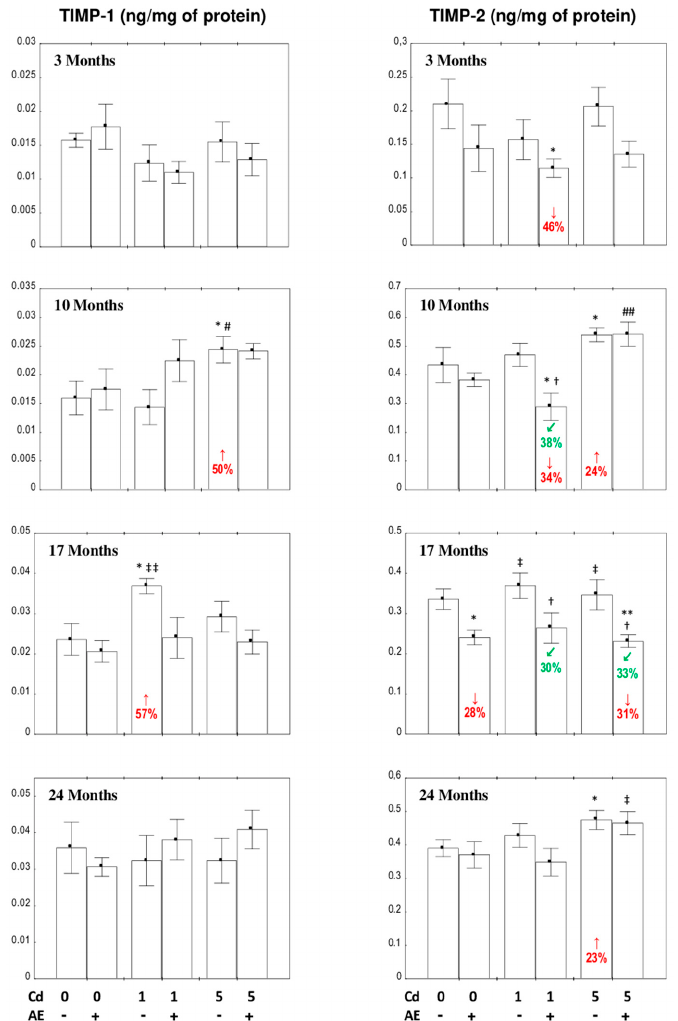
Figure 7. The impact of Aronia melanocarpa L. berry extract (AE) on the concentrations of tissue metalloproteinase inhibitor-1 (TIMP-1) and tissue metalloproteinase inhibitor-2 (TIMP-2) in the livers of rats exposed to cadmium (Cd). The animals were treated with Cd at the concentrations of 0, 1, and 5 mg Cd/kg in their diets and/or 0.1% aqueous AE (+) or not ( − ). Data are shown as mean ± SE for eight rats, except for seven animals in the AE, Cd 1 , and Cd 5 groups after 24 months. Statistically significant differences (Kruskal–Wallis post hoc test): * p < 0.05 and ** p < 0.01 vs. control group; † p < 0.05 vs. appropriate Cd group; ‡ p < 0.05 and ‡‡ p < 0.01 vs. AE group; # p < 0.05 and ## p < 0.01 vs. appropriate group maintained on the 1 mg Cd/kg diet (Cd 1 group or Cd 1 + AE group). Numerical values in bars express the percentage changes in comparison to the control group ( ↑ , increase; ↓ , decrease) or the appropriate group exposed to Cd alone ( ↙ , decrease).